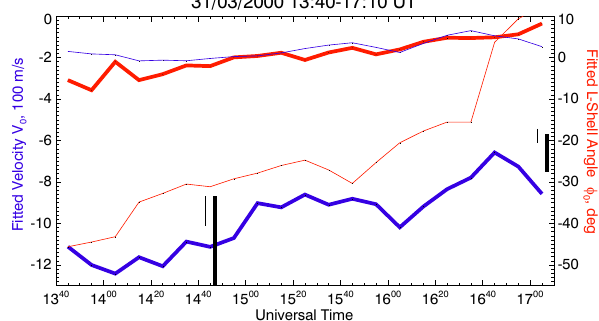
Fig. 4. Time variation of the fitted velocity V 0 (blue) and L -shell angle φ 0 (red) during the considered period. The scale for the fit- ted velocity ( L -shell angle) is shown on the left (right) axis. Thin (thick) line represents the results of fitting for E- (F-) region. Verti- cal thin (thick) black lines show the span (minimum to maximum) of the DMSP measurements of the ion drift in the latitudes corre- sponding to E- (F-) region for the two passes over the FoV shown in Fig.